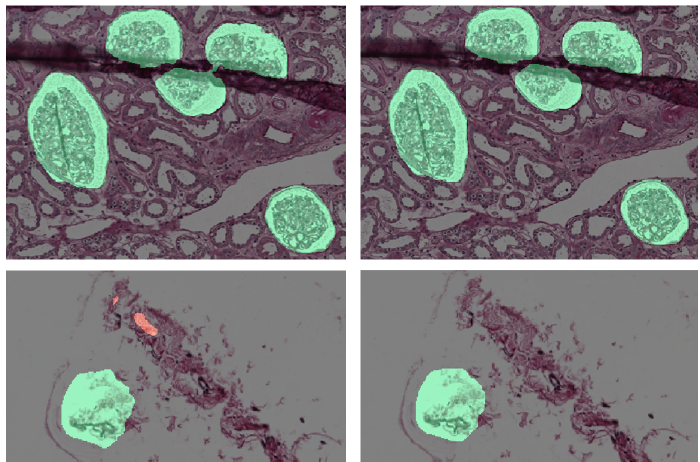
Figure 4. ( Left ) Semantic Segmentation output. ( Right ) After Morphological